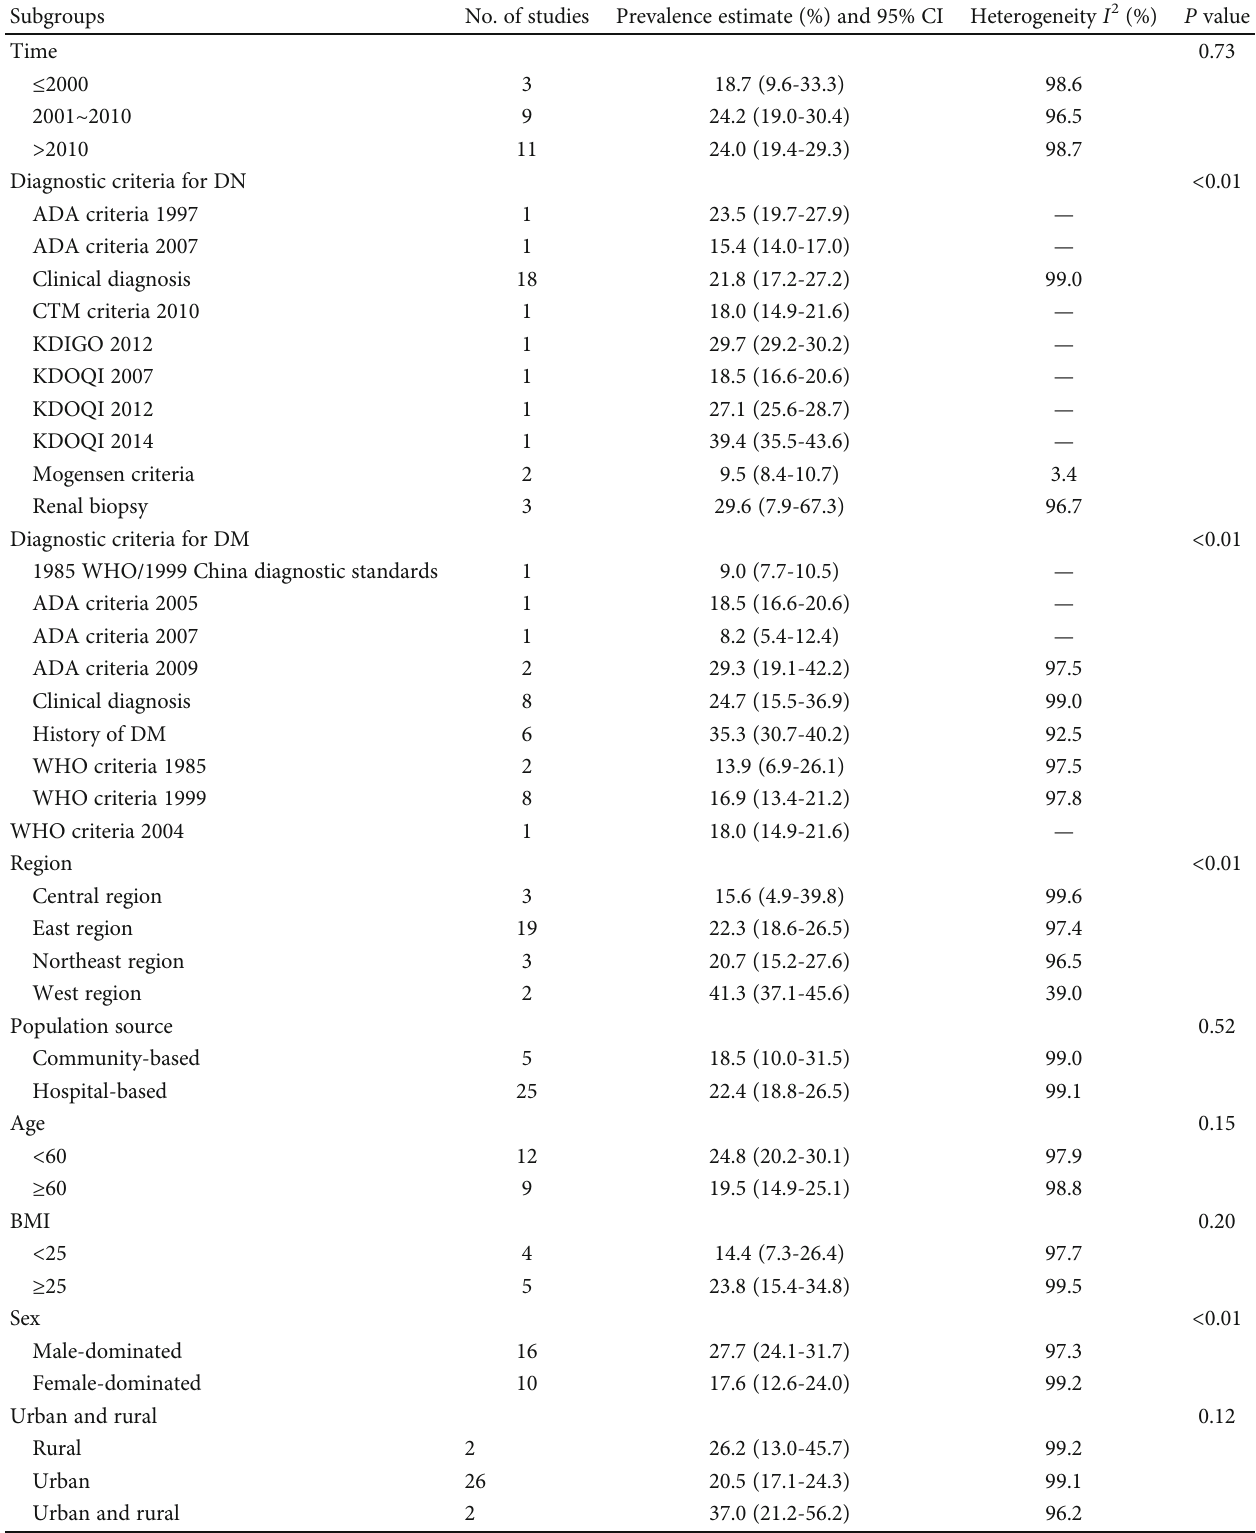
Table 2: Prevalence of DN by study and design